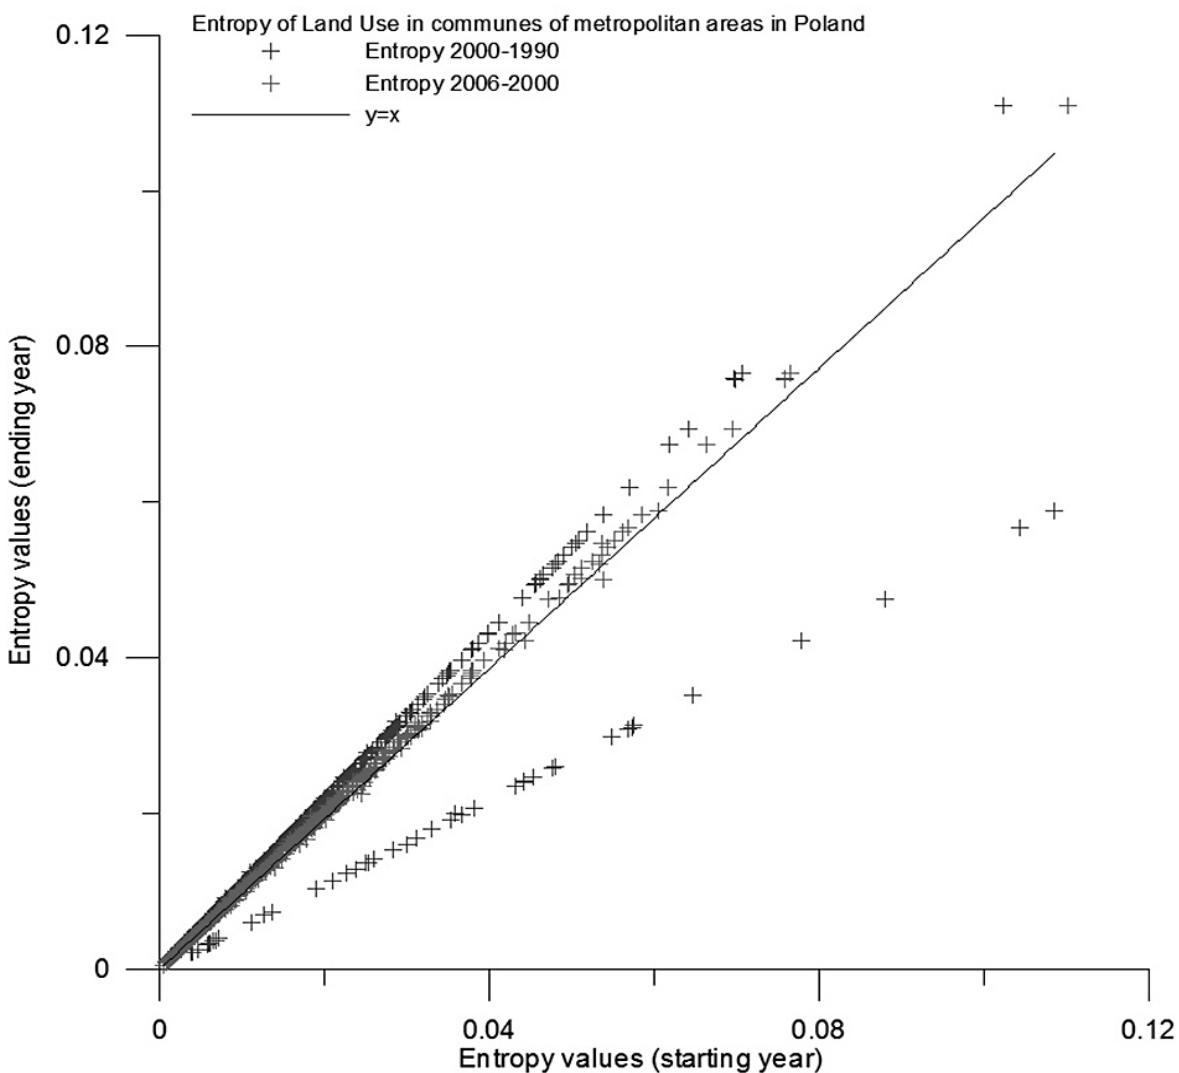
Fig. 6. Entropy of land use in municipalities of the metropolitan areas in Poland